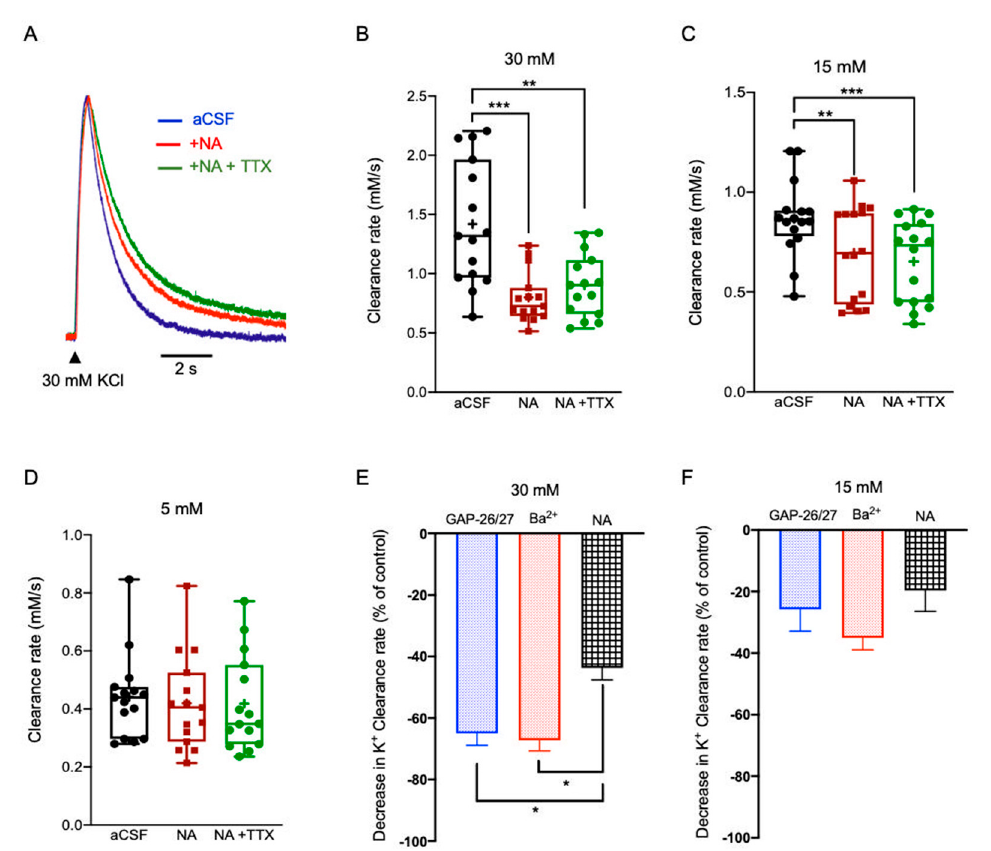
Figure 5. The impact of NA on the K + clearance rate and astrocytic Ca 2+ signaling. ( A ) Sample traces of [K + ] o recordings depicting the K + clearance time course following local application of 30 mM KCl (arrow), before (aCSF, blue) and after application of Noradrenaline bitartrate (40 µM, NA, red) or NA with 1 µM TTX (green). ( B – D ) Box plots depicting the K + clearance rate following local application of KCl at 30 mM ( B ), 15 mM ( C ) and 5 mM ( D ), before (aCSF, black dots) and after bath application of NA without (red dots) or with TTX (green dots). ( E , F ) Bar graphs depicting the average decrease in K + clearance rate (as % from control) following blockade of Kir4.1 channels by Ba 2+ (red); blockade of Cx43 channels by a mix of GAP26/27 mimetic peptides (blue), or photolysis of DA (black) together with the local application of 30 mM ( E ) or 15 mM ( F ) KCl. Box plot definitions is the same as in Figure 1. * p < 0.05; ** p < 0.01; *** p < 0.0001, two-way